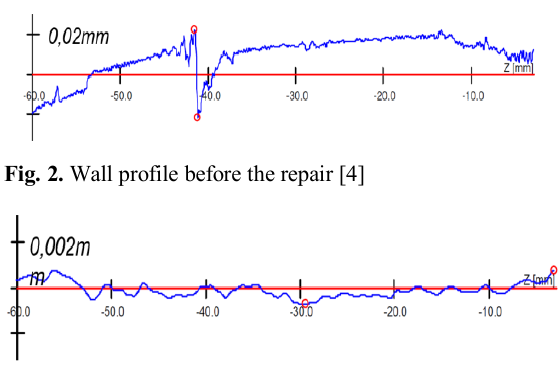
Fig. 3. Wall profile after the repair [4]